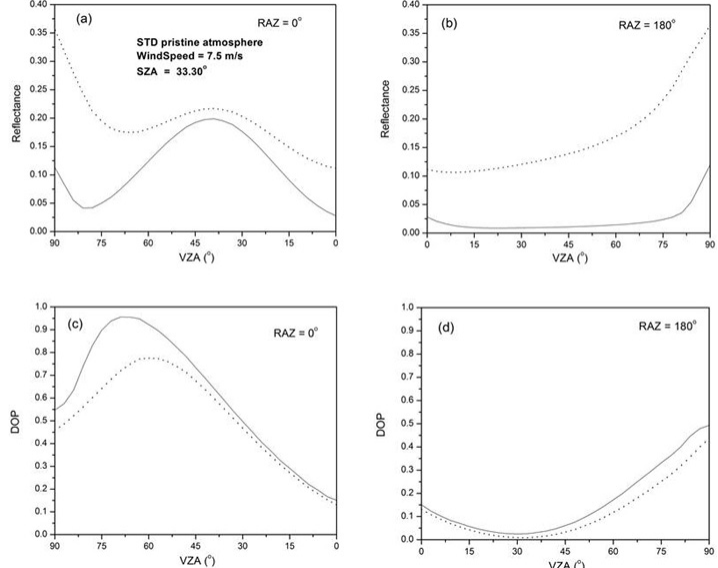
Fig. 14. The total reflectance and DOP of the ocean–atmosphere system on the principal plane, which is calculated with the ADRTM at the wavelengths of 470nm (dashed curve) and 865nm (solid curve), respectively. Pristine US standard (STD) atmosphere is used. The solar zenith angle is 33.30 ◦ . Wind speed is 7.5ms − 1 .